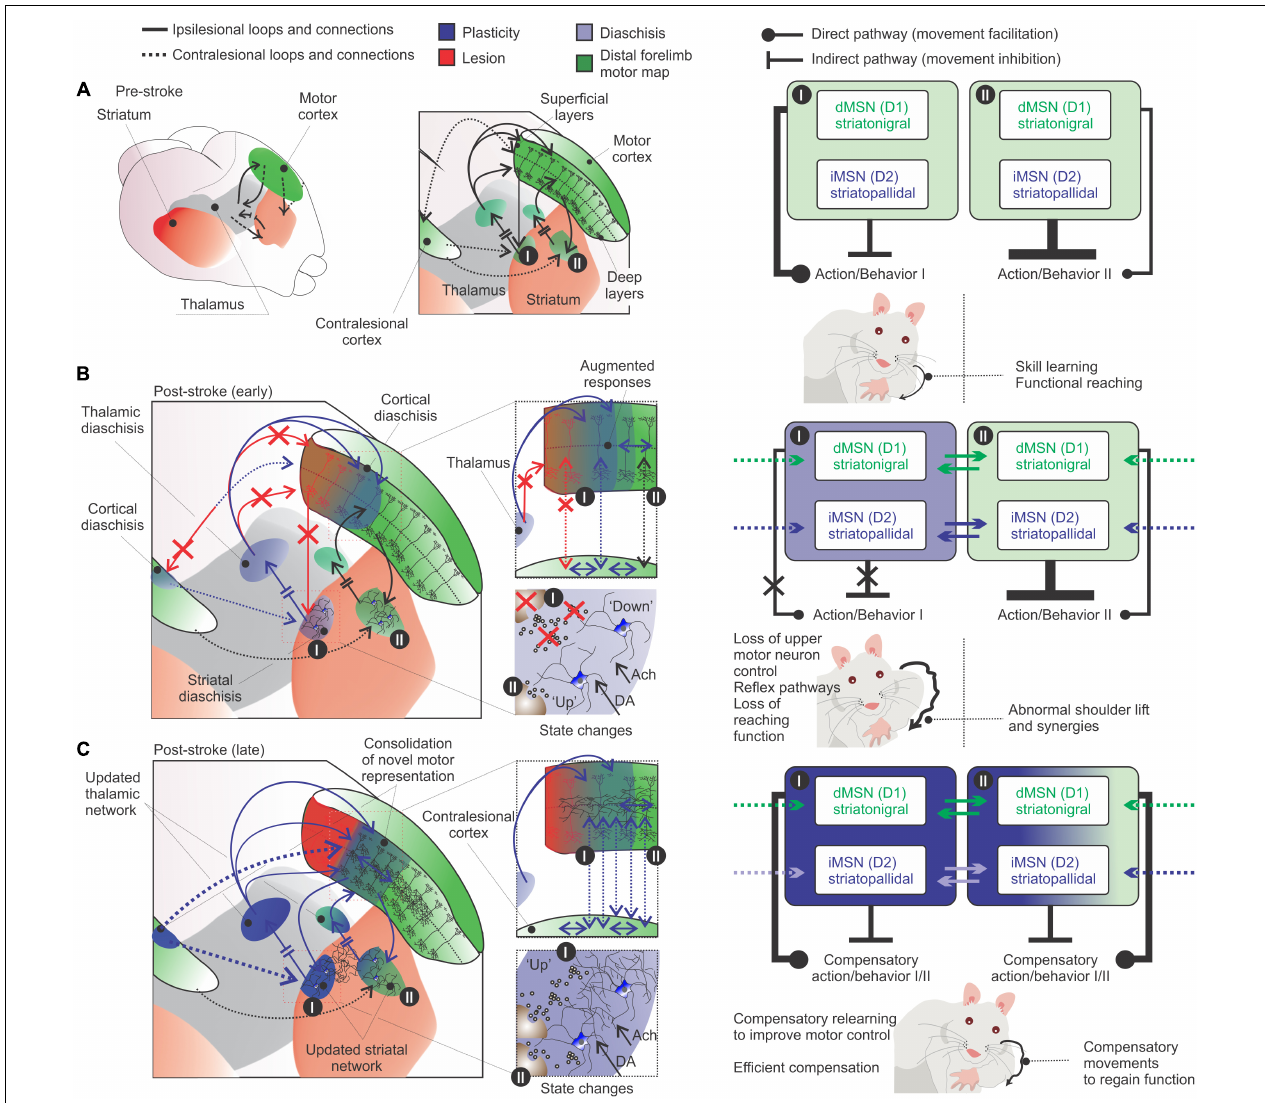
FIGURE 5 | Diaschisis as a consolidation-reconsolidation process. ( A , left) Movement before stroke involves the selection of the appropriate motor program for the specific action (cortico-striatal-thalamo-cortical loops). ( A , right) Specific actions are linked to specific cortico-striatal-thalamo-cortical loops. This specific functional region may control a voluntary movement, using the appropriate motor sequence for a coordinated muscular action. ( B , left panels) Following stroke, diaschisis of regions close or distant to the infarct core (light blue) affects the functionality of the motor network and disrupts or change the specific action (red arrows: lost connections; blue and black arrows: remaining connections). ( B , right panels) This results in loss of upper motor neuron control over voluntary movements and the emergence of abnormal movements (Balbinot et al., 2018). Compensatory relearning is unlikely to fully restitute movements of the paretic limb, which should retain some of the abnormalities and deficits in the specific action. Functional compensatory movements may be reinforced by lateral inhibition between ipsilesional MSNs (solid lines; the striatal region I influence striatal region II) and/or contralesional cortico-striatal connections (hashed lines). This reinforcement is shaped by striatal state changes and cortical plasticity. (C) Rehabilitation provides the recollection of visual, tactile and motor cues: the motor output is a changed action tailored over many rehabilitation sections during the “striatal search task” and the “cortical learning mode”. It is likely that consolidation–reconsolidation mechanisms are slowly acting to shape these circuits during rehabilitation. Compensatory brain regions may supplement function of damaged areas and a novel motor engram is formed (dark blue) (e.g., Kim et al., 2018). The system is shaped toward the specific actions used over rehabilitation sections. Hence, the generation of a novel motor engram is supported by a series of adjustments in connections of the redundant motor system network. Right panels in (A–C) are inspired by a new perspective for striatal local circuitry plasticity (Burke et al., 2017). The authors explore how lateral inhibition (between MSNs) can contribute to the formation of functional units to process, integrate and filter inputs to generate motor patterns and learned behaviors (Burke et al.,